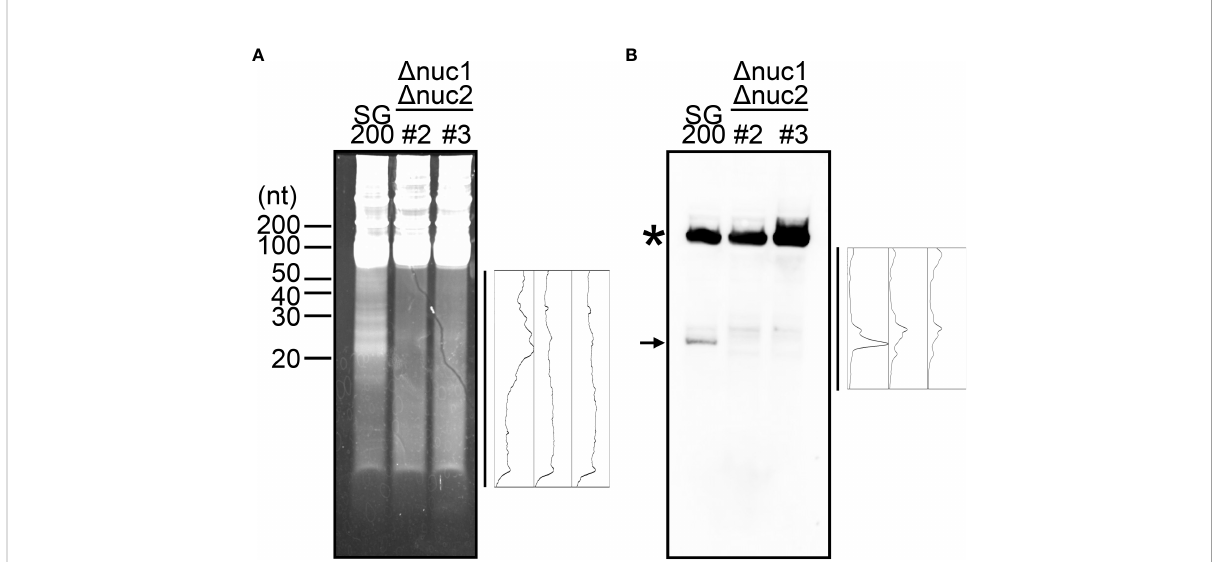
FIGURE 3 Visualization of small non-coding RNAs in the double deletion mutants of nuc1 and nuc2 in U. maydis . (A) Electrophoresis of total RNAs extracted from SG200 and SG200 D nuc1 D nuc2 mutants (designated as #2 and #3). Densitometry of small RNA bands in an indicated area was shown at the right of panel. (B) Northern blot analysis for the detection of tRNA-Gly fragment in SG200 and SG200 D nuc1 D nuc2 mutants. Asterisk indicates the full-length tRNA-Gly. Arrow indicates a major 5 ’ -tRNA fragment generated from full-length tRNA-Gly. Densitometry of tRNA fragment signals in an indicated area was shown at the right of